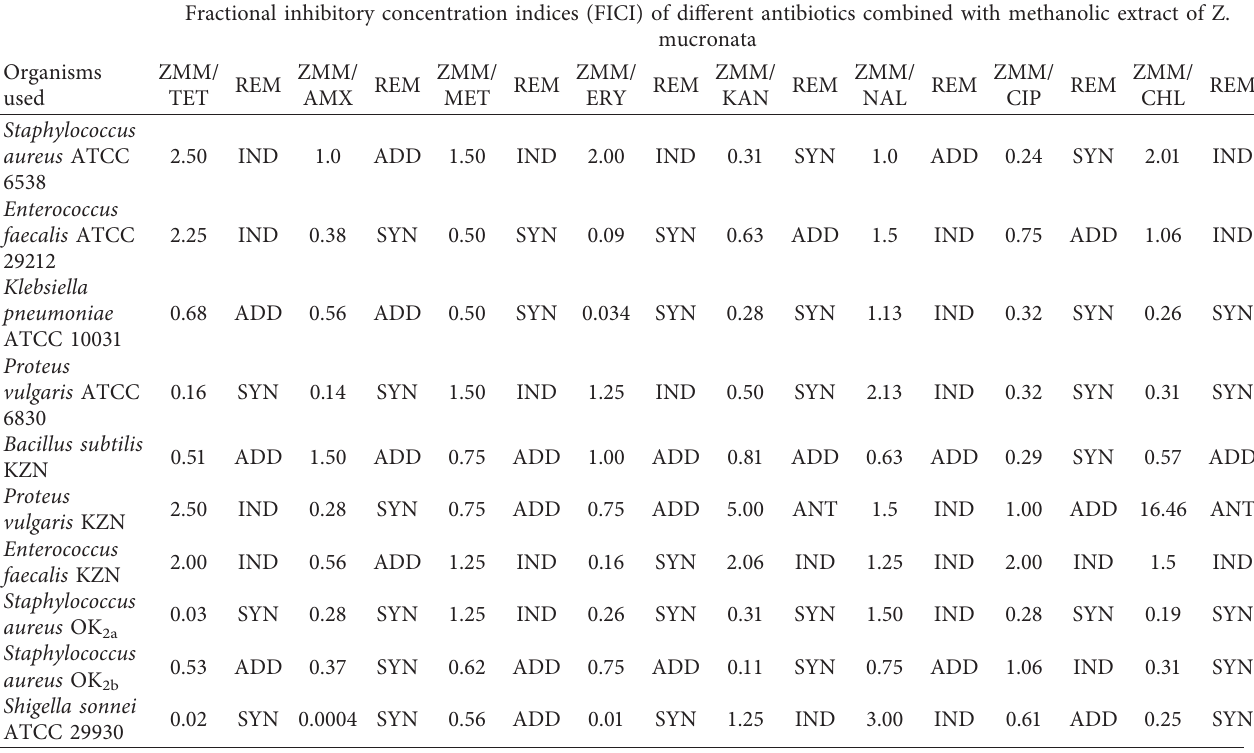
Table 5: Fractional inhibitory concentration indices of the antibacterial